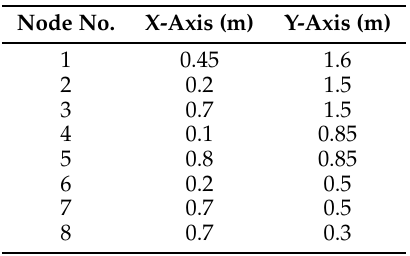
Table 5. The coordinates of nodes deployed on the human body.